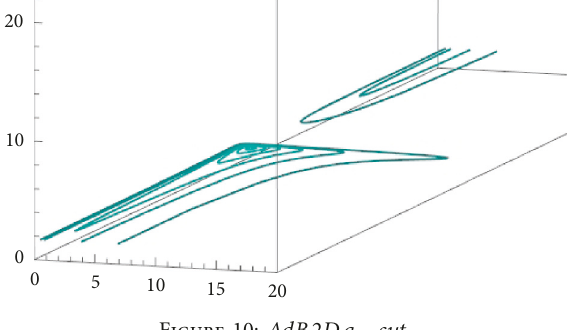
Figure 10: AdB 2 Da − cut .